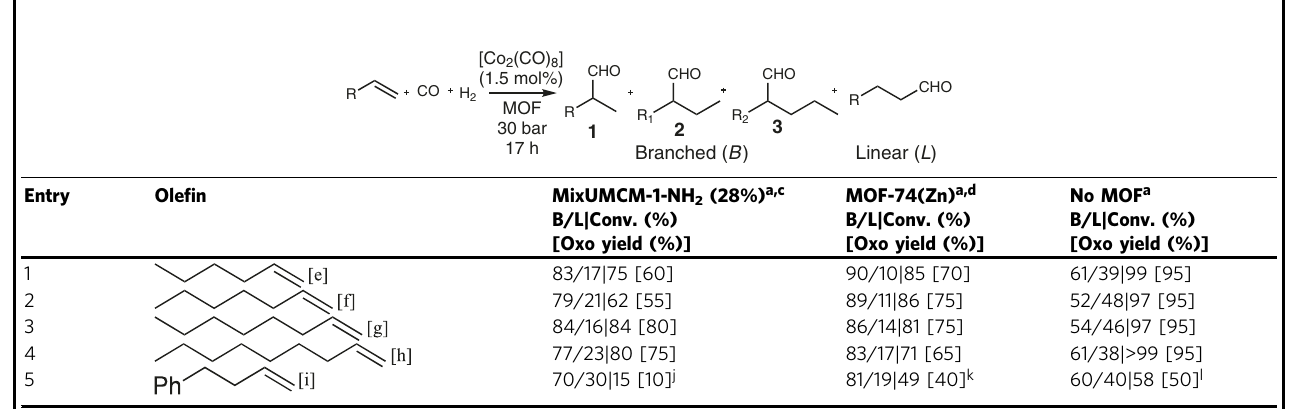
a Conv. = ole fi nsconversion;Oxoyield = yieldofoxoproducts.B/LandconversionwerecalculatedusingGC-FIDwith p -cymeneasexternalstandard.Oxoproductsyieldwascalculatedbycombiningthe mass of the raw product after reaction and the purity determined by GC-FID (see Supplementary Information). The oxo products were identi fi ed as aldehydes (Supplementary Table 10) and aldol condensation